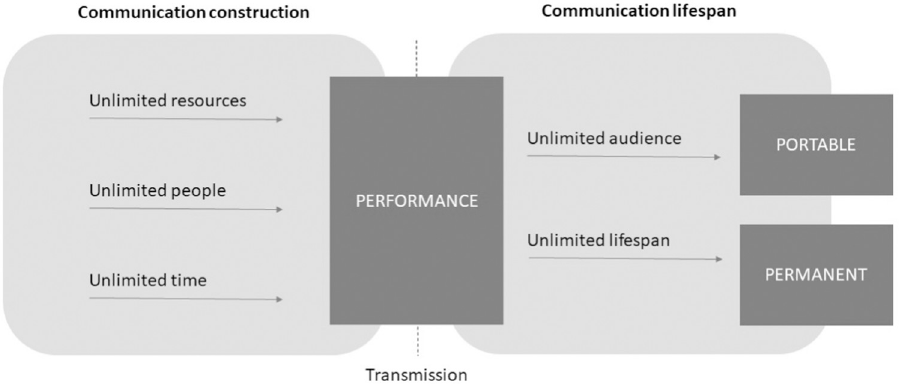
Fig 1. Portable and permanent performances. Individuals have unlimited time and resources at their disposal— including collaboration with team members—to craft a digital message. Once that message is sent, however, it becomes fossilized and the recipient may easily share it with anyone without the sender’s knowledge or